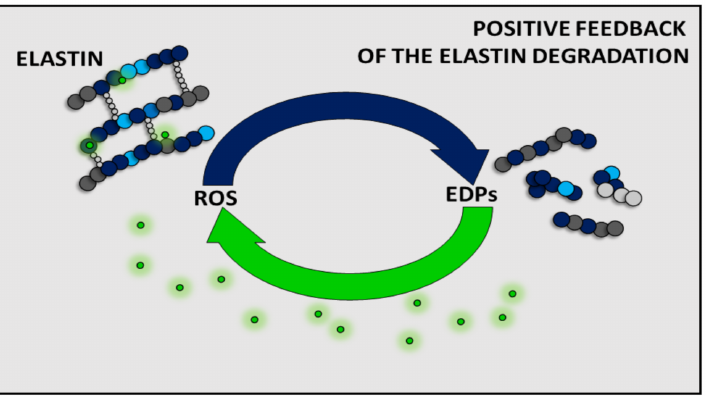
Figure 3. Summarizing scheme of the positive feedback of reactive oxygen species (ROS) and elastin degradation yielding elastin-derived peptides